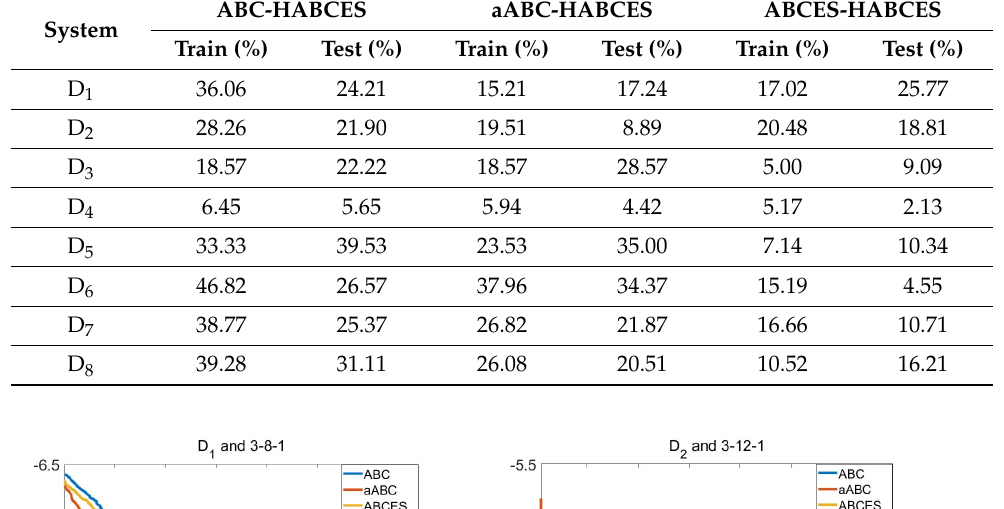
Table 12. Performance increase achieved using HABCES for nonlinear dynamic system identification.